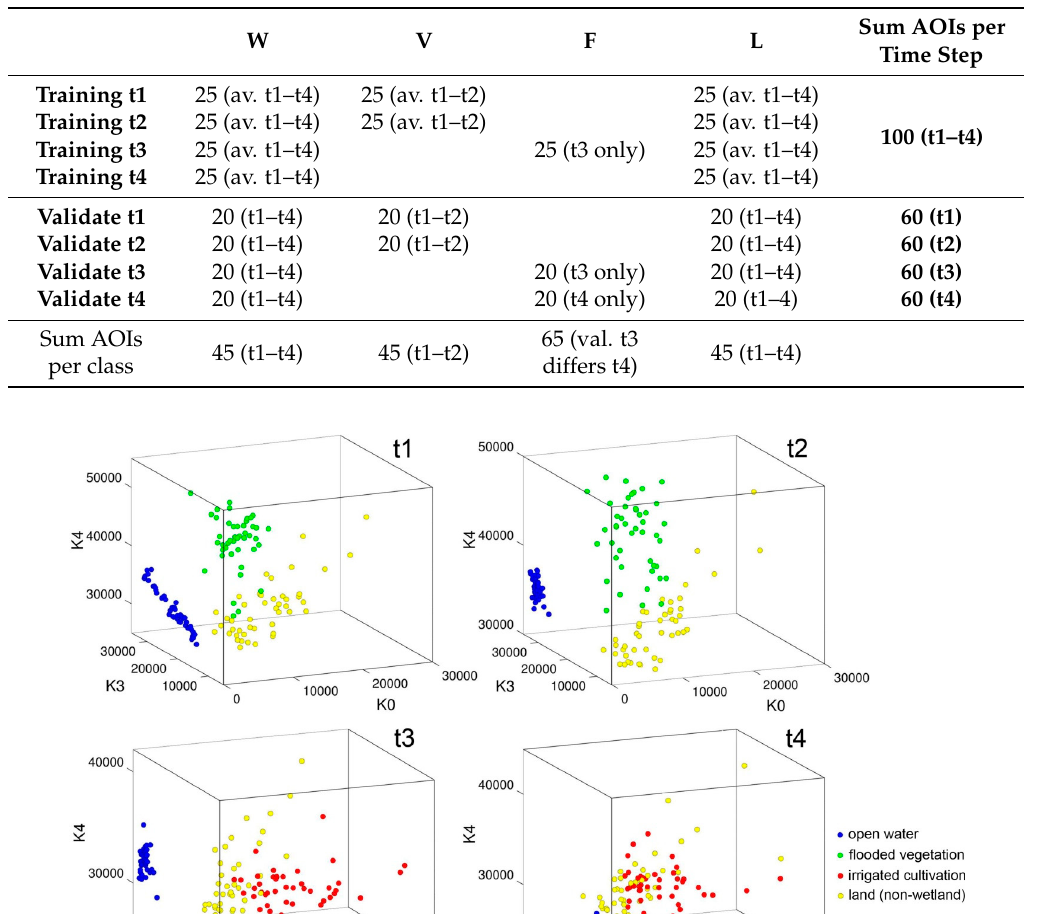
Table 4. Areas of interest (AOIs) for the training dataset (averaged for t1–t4) and validation dataset (for each image t1–t4) of the monotemporal classification applied on each image in the time series: W (water); V (flooded/floating vegetation); F (irrigated fields); L (land).